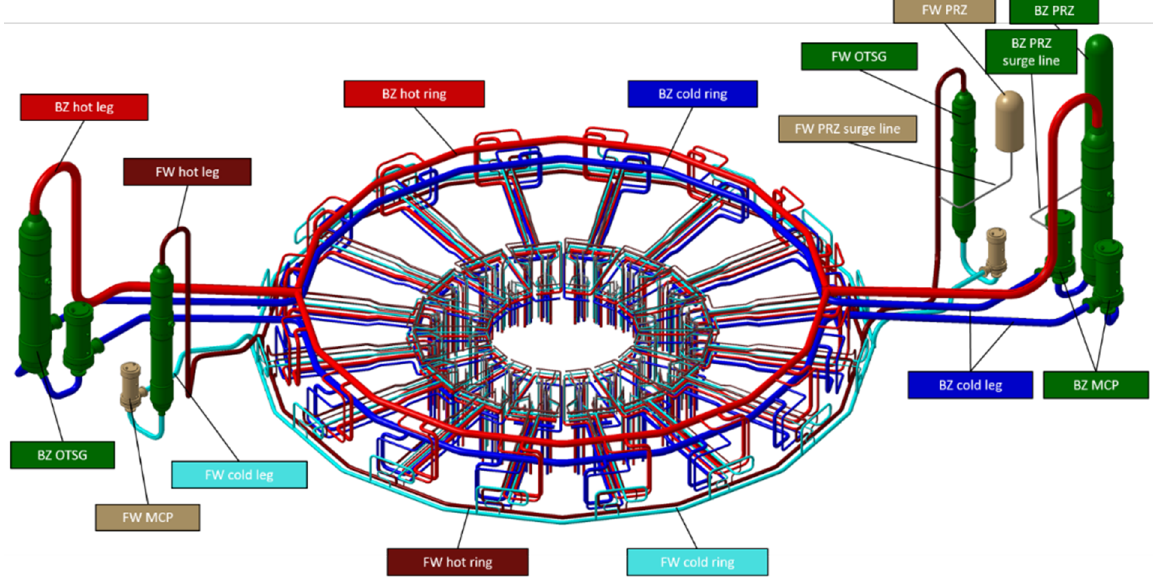
Figure 1. Overview of the DEMO WCLL BB PHTS.